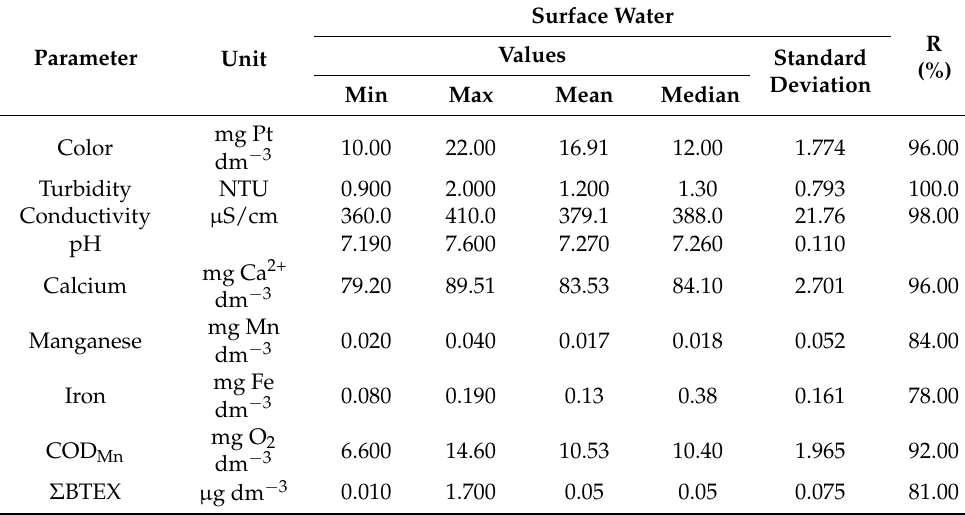
Table 3. Quality of surface water used in the